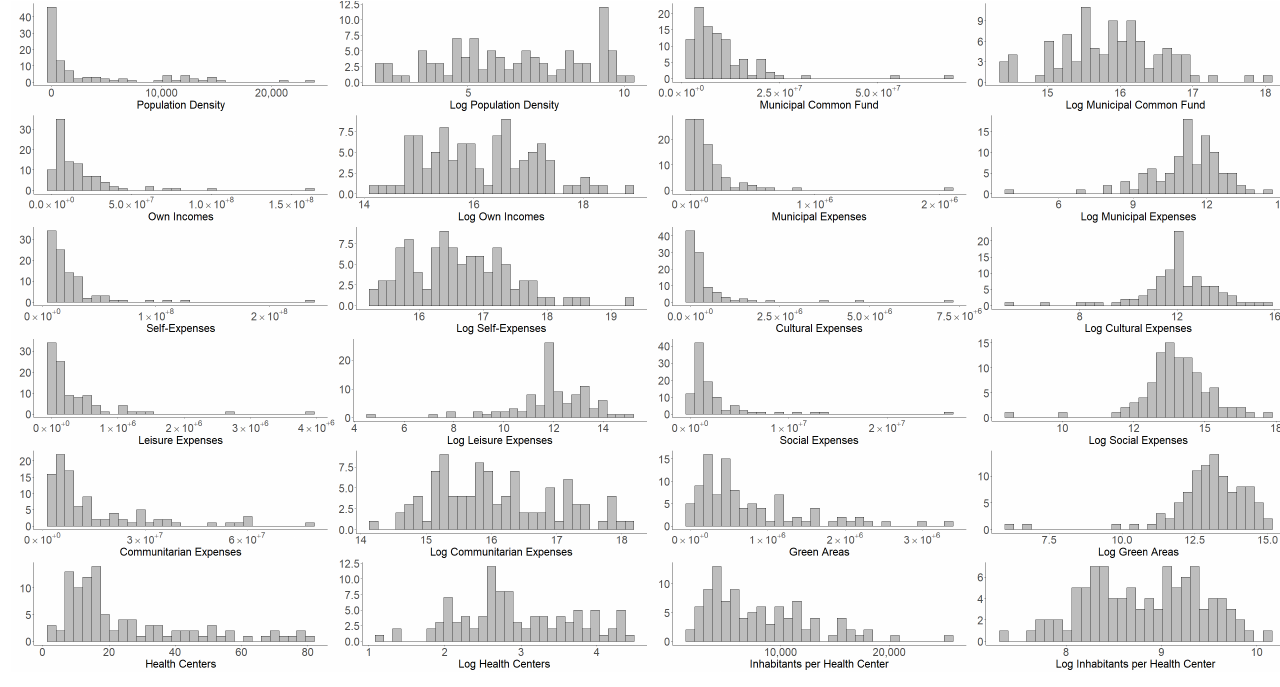
Figure 4. Variable transformations.